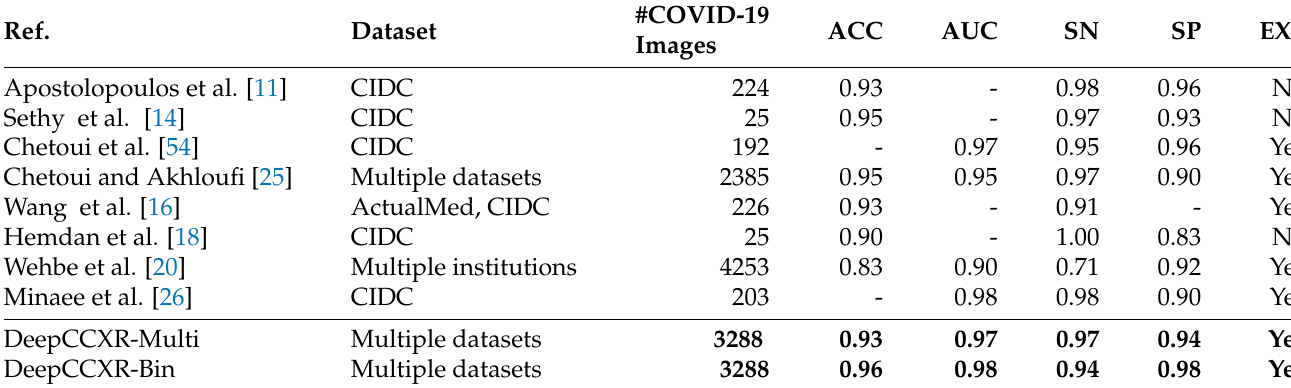
Table 4. Performance comparison with state-of-the-art methods using CXR images for COVID-19 detection.